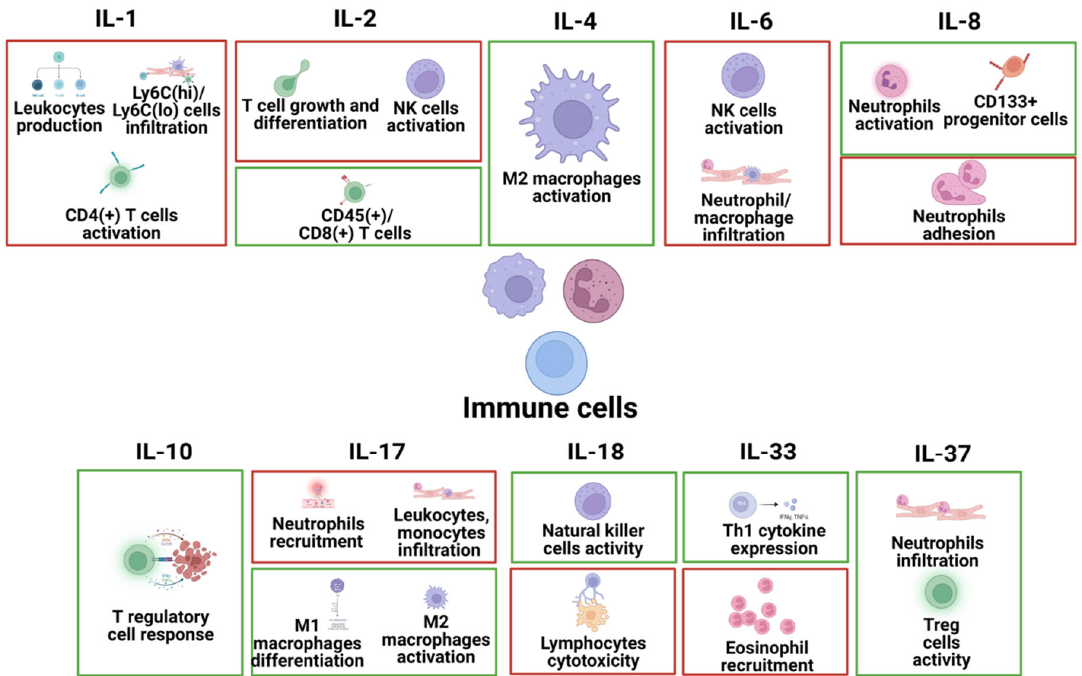
Figure 4. The speci fi c pathophysiological e ff ects of di ff erent interleukins on immune cells in com- mon heart disease. The box in red represents the deleterious role, and the box in green represents the protective